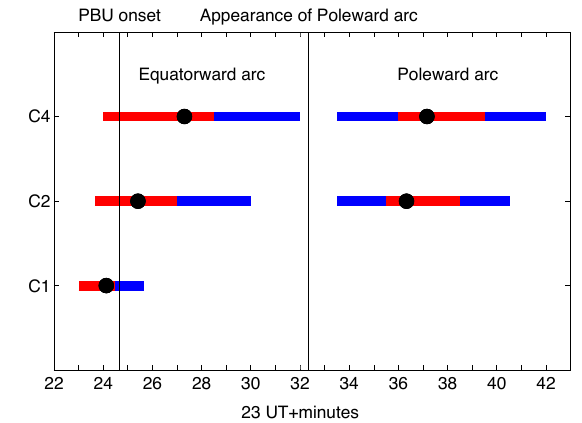
Fig. 3. FAC densities for C1, C2 and C4 as a function of ge- ographic latitude, positive values mean upward current from the ionosphere. Arrows show the location of the maximum upward FAC and solid horisontal lines indicate the estimated widths of the current sheets. The times corresponding to arrows from top to bot- tom are: 23:24:10 UT, 23:25:25 UT and 23:27:20 UT.